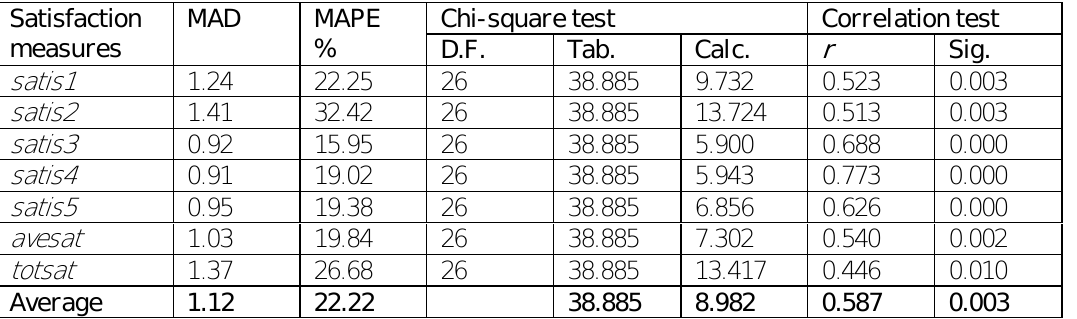
Chi-square test Correlation test Satisfaction